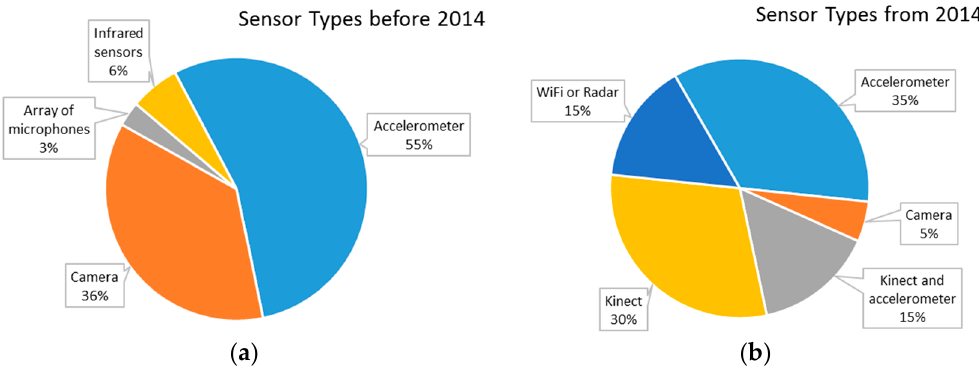
Figure 1. Comparison of types of sensor used in fall detection system: ( a ) the proportion of different types of sensor used in fall detection systems before 2014; and ( b ) the proportion of different types of sensor used in fall detection systems from 2014. Note that “Kinect and accelerometer” represents systems using both.